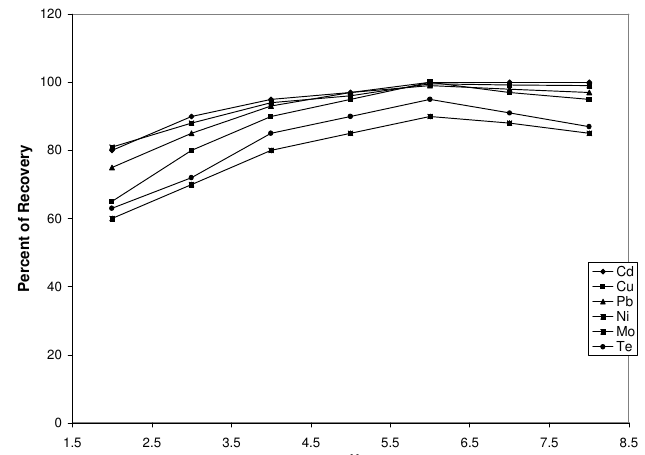
Figure 2. Effect of pH on the Complexation of Metal with Coniinedithio